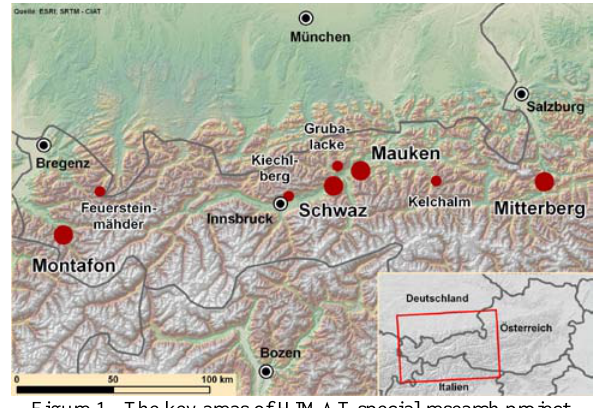
Figure 1. The key areas of HIMAT special research project,